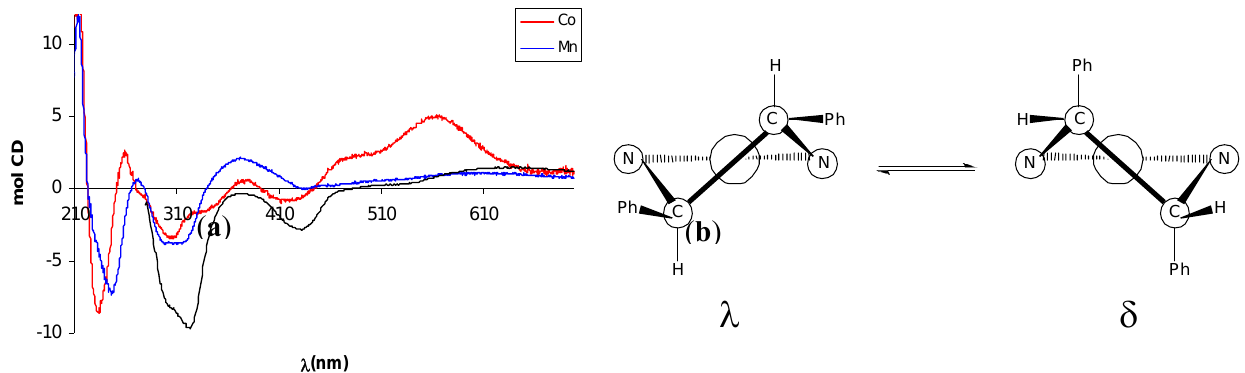
Figure 4. (a) CD spectra of Mn(III)-complex (–)- 10 and Co(II)-complex (+)- 11 . Black line . (b) Conformations and phenyl orientation for ( R,R )-dpen refers to (–)- 10 in CHCl 3 diamine chelate ring.